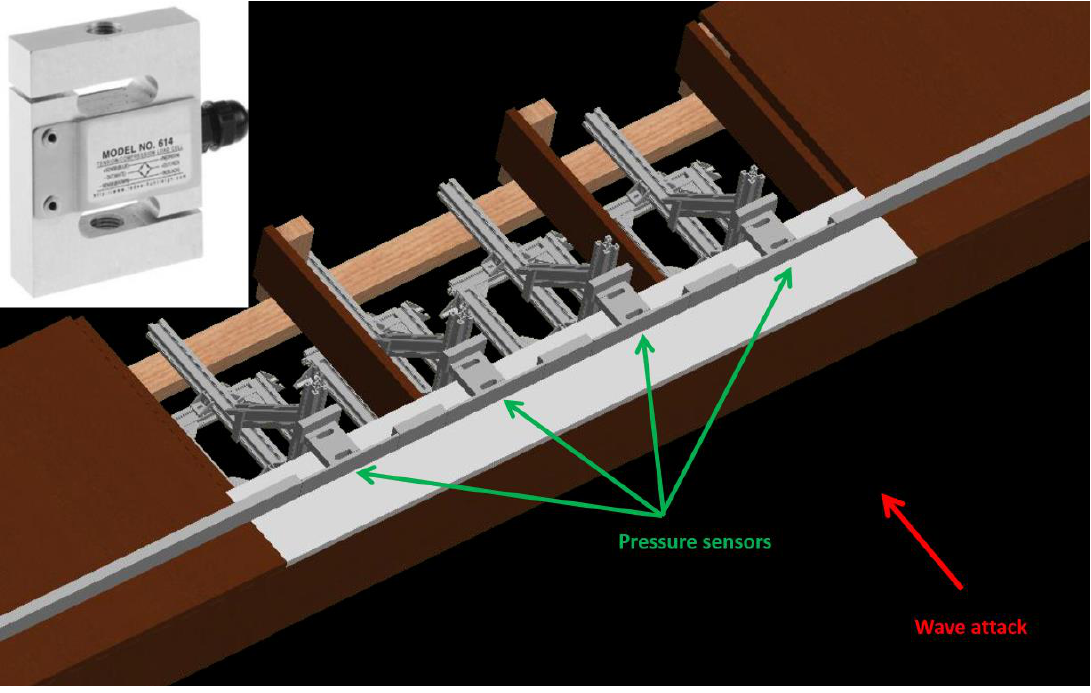
Figure 6. Force sensors were installed location as designed.